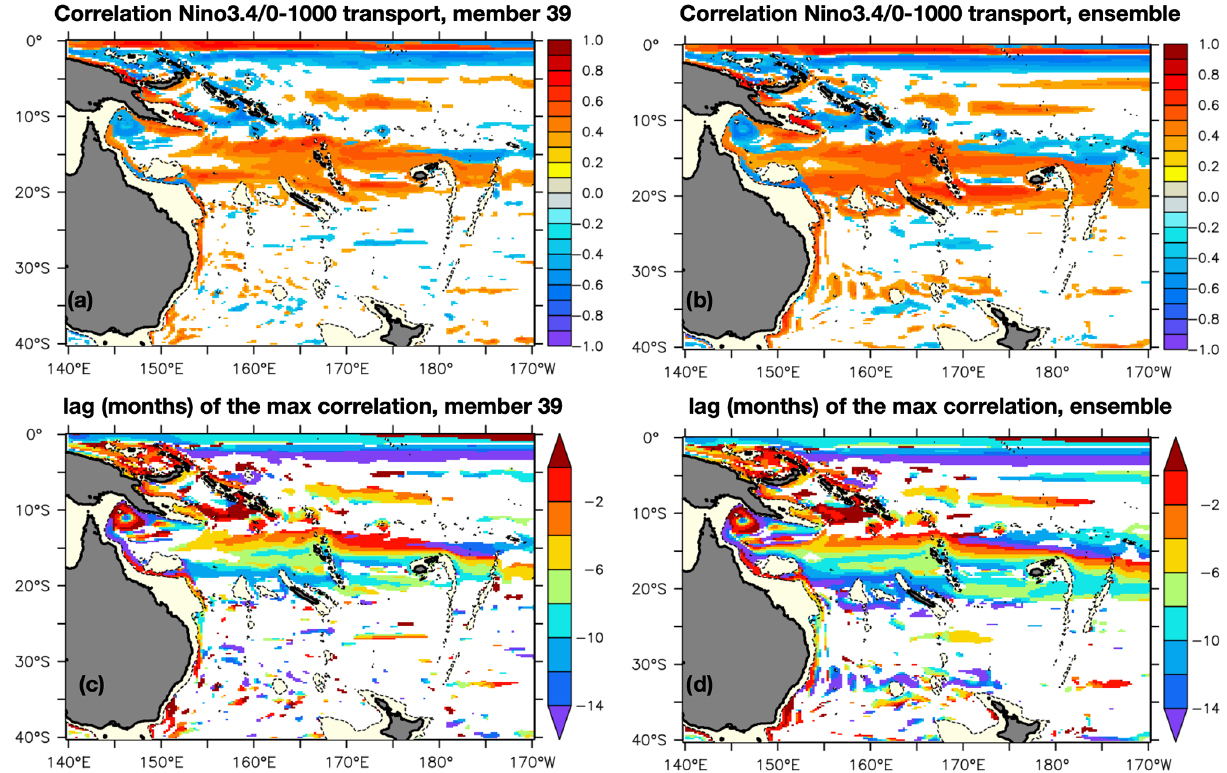
Figure 7. Maximum lagged correlation (a, b) and corresponding lag in months (taken between − 15 and 5 months) (c, d) between the Nino3.4 index and the 0–1000m interannual transport variations for (a, c) member 39 of the ensemble and (b, d) the ensemble mean. A negative lag means that Nino3.4 leads the transports variations. Only significant correlations are